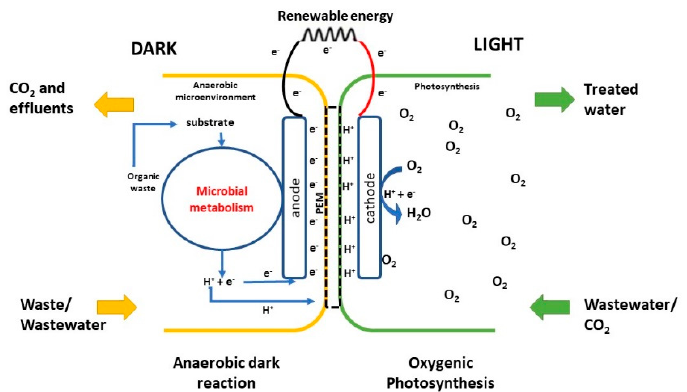
Figure 4. Diagram of a microbial fuel cell Figure 4 : Diagram of a microbial fuel cell (MFC) .